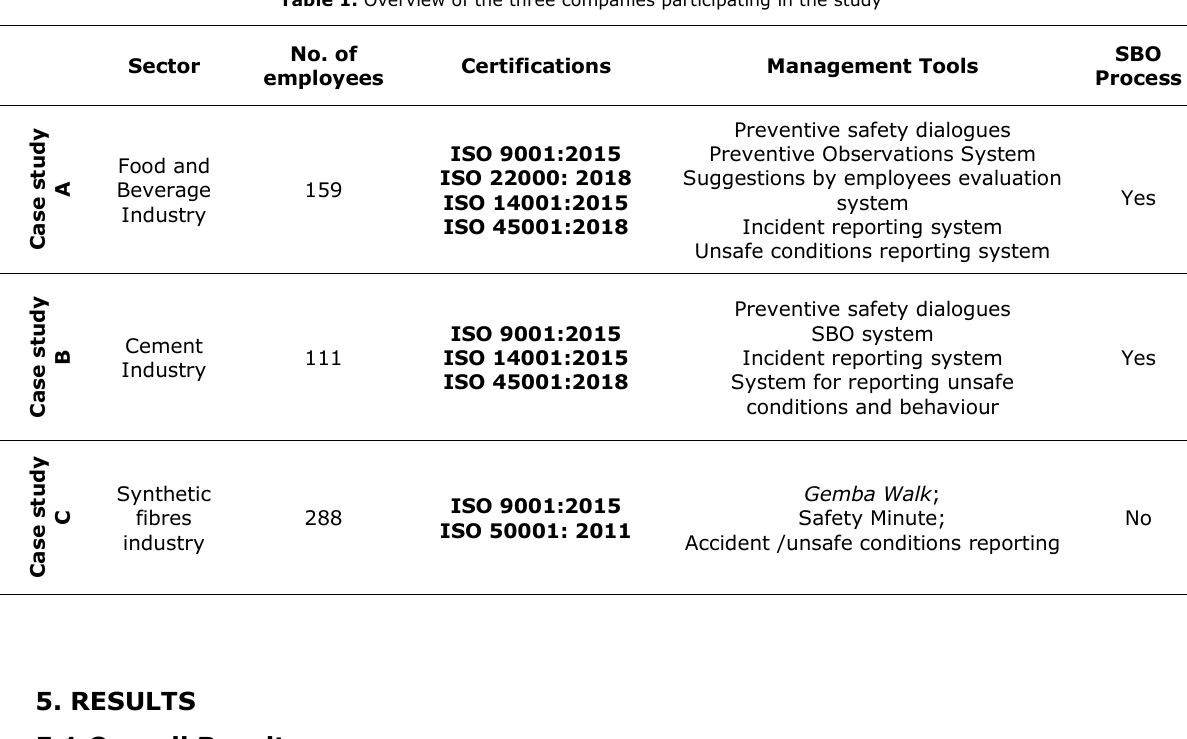
Table 1. Overview of the three companies participating in the